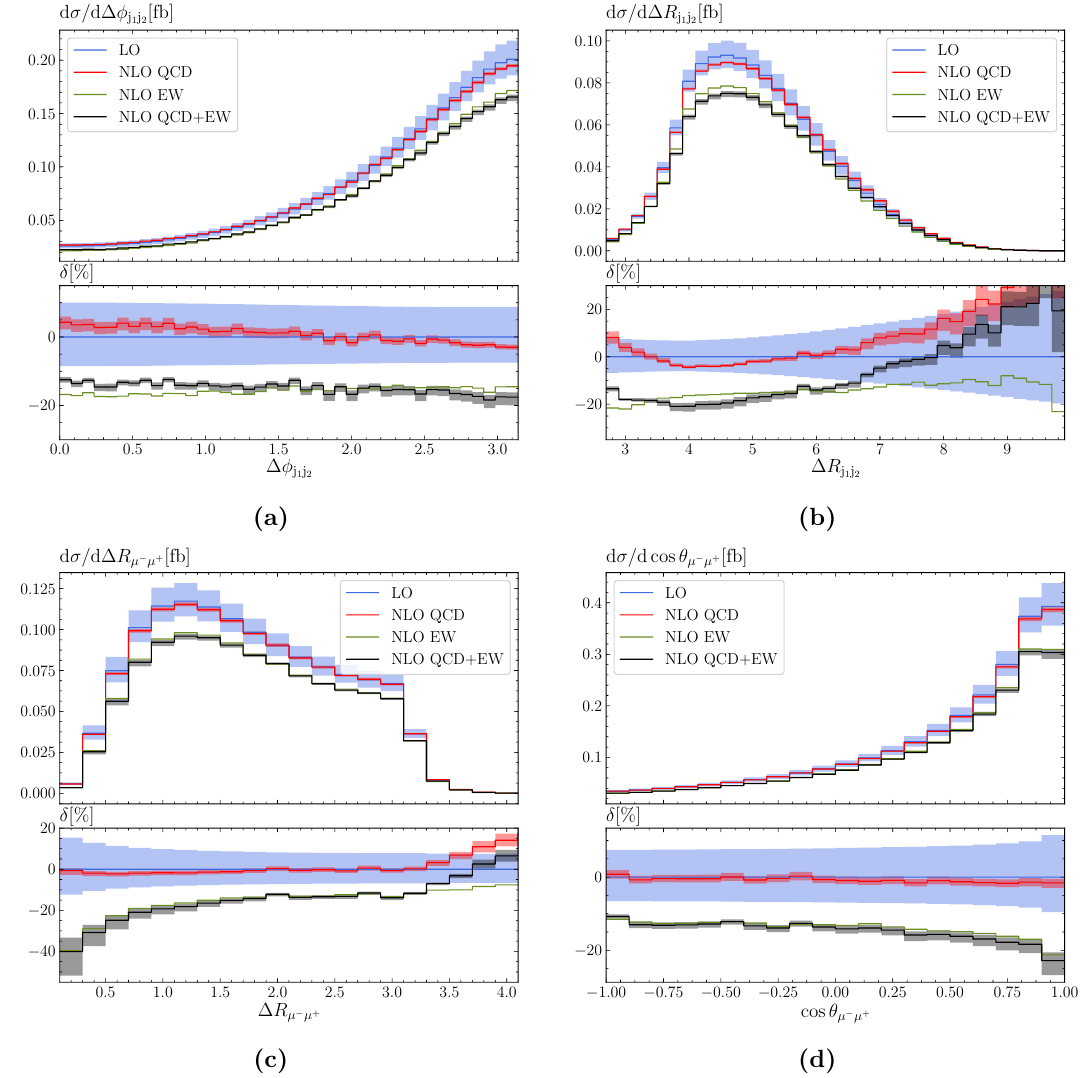
Figure 8. Di(cid:11)erential distributions for pp (cid:22) + (cid:22) (cid:0) e + (cid:23) e jj+ X at the LHC with CM energy 13 TeV: ! (a) azimuthal angle between the two tagging jets (top left), (b) rapidity-azimuthal-angle distance between the two tagging jets (top right), (c) rapidity-azimuthal-angle distance between the muon and anti-muon (bottom left), and (d) cosine of the angle between the muon and anti-muon (bottom right). The upper panel shows the LO contributions of order (cid:11) 6 , the two NLO predictions O [including (NLO EW) and (cid:11) s (cid:11) 6 (NLO QCD)] as well as their sum. The lower panel (cid:0) (cid:1) O O shows the relative NLO corrections with respect to the LO in percent. (cid:0) (cid:1)